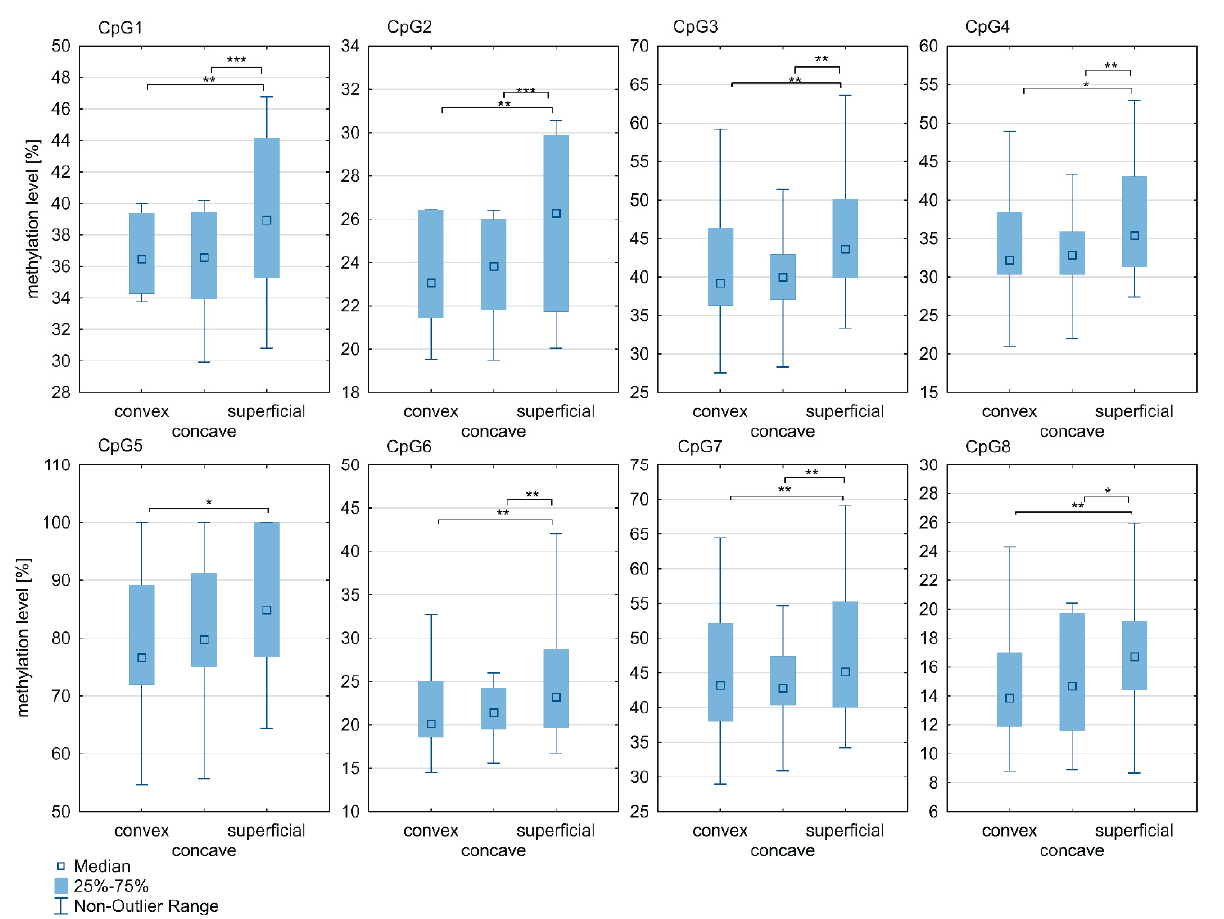
Figure 4. DNA methylation level within ESR1 T-DMR2 region in deep paravertebral muscles and superficial muscles; * p < 0.05, ** p < 0.01, *** p < 0.001.